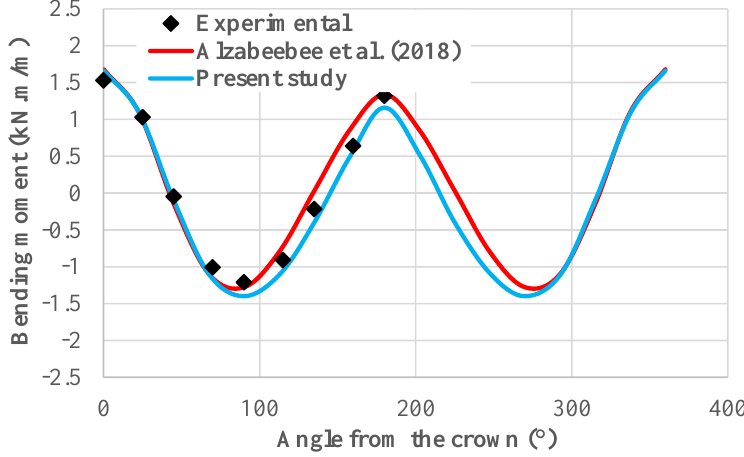
Figure 4. Calculated and predicted bending moment values developed in the pipe wall for a concrete pipe buried with backfill height of 0.6 m and subjected to the AASHTO standard dual-tire load [27].